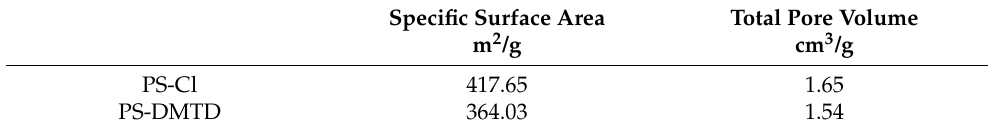
Figure 3. ( a ) N 2 adsorption – desorption isotherms for PS-Cl and PS-DMTD and ( b ) the correspond- ing pore size distribution (BJH). Table 1. BET data of PS-Cl and PS-DMTD. Table 1. BET data of PS-Cl and PS-DMTD.